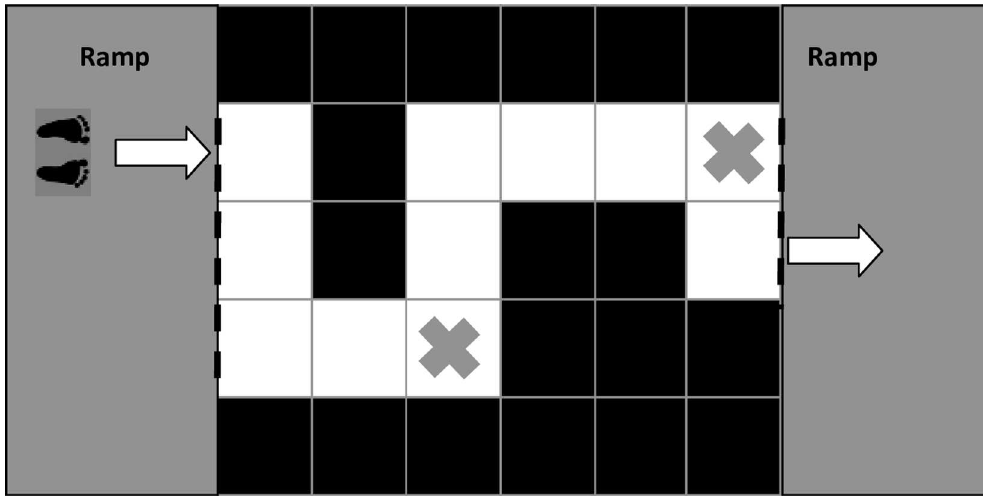
Fig 1. Schematic of an example path and direction of walking. The arrows indicate the route that participants took (returning on the left side of the walkway in all trials). Blocks marked with an ‘X’ were participants’ precision stepping targets. Dotted black lines indicate the points between which the time to complete the walking task was